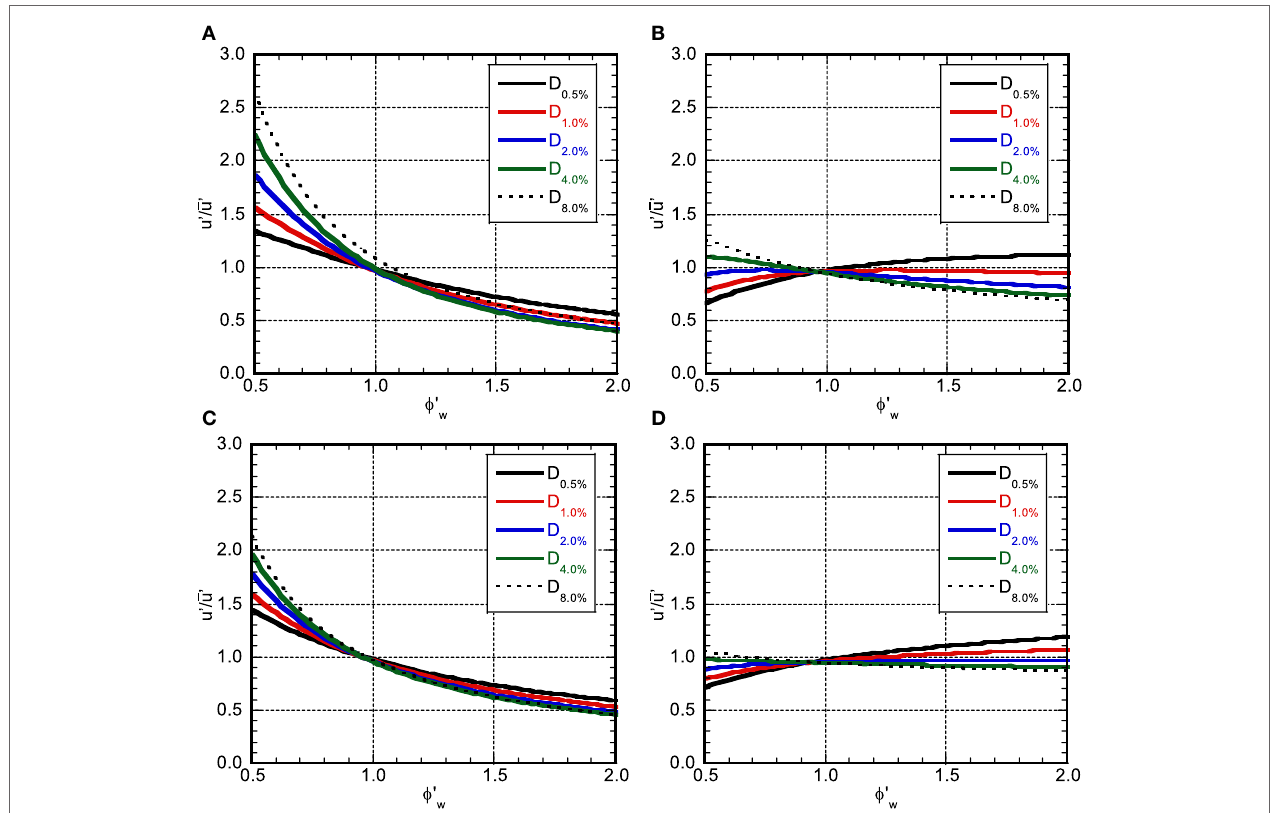
(cid:22) h ): (A) upper structure ( H w / H :0.2), (B) lower structure ( H w / H :0.2), (C) upper structure ( H w / H :0.5), and 1 Δ